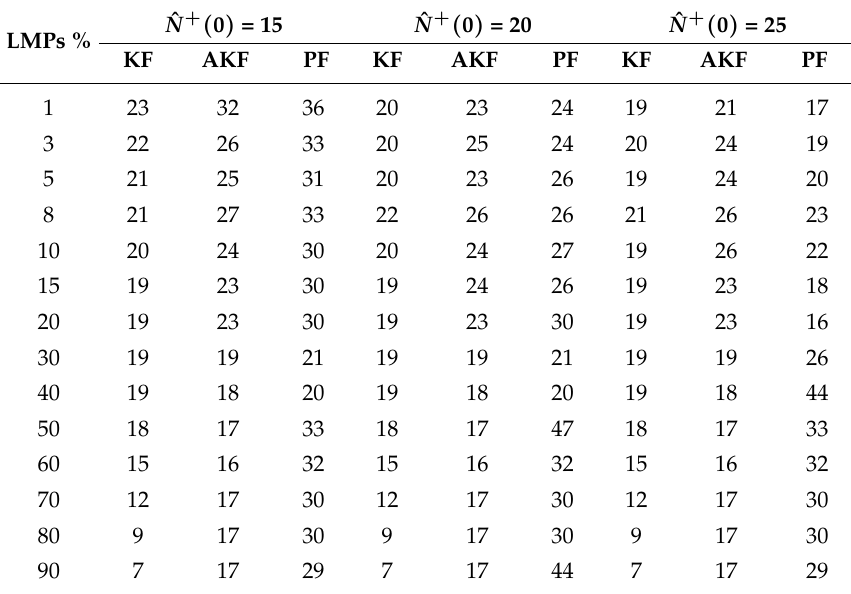
Table 4. RRMSE values for the KF, AKF, and PF approaches using different initial vehicle count estimates (i.e., 15, 20 and 25) for different